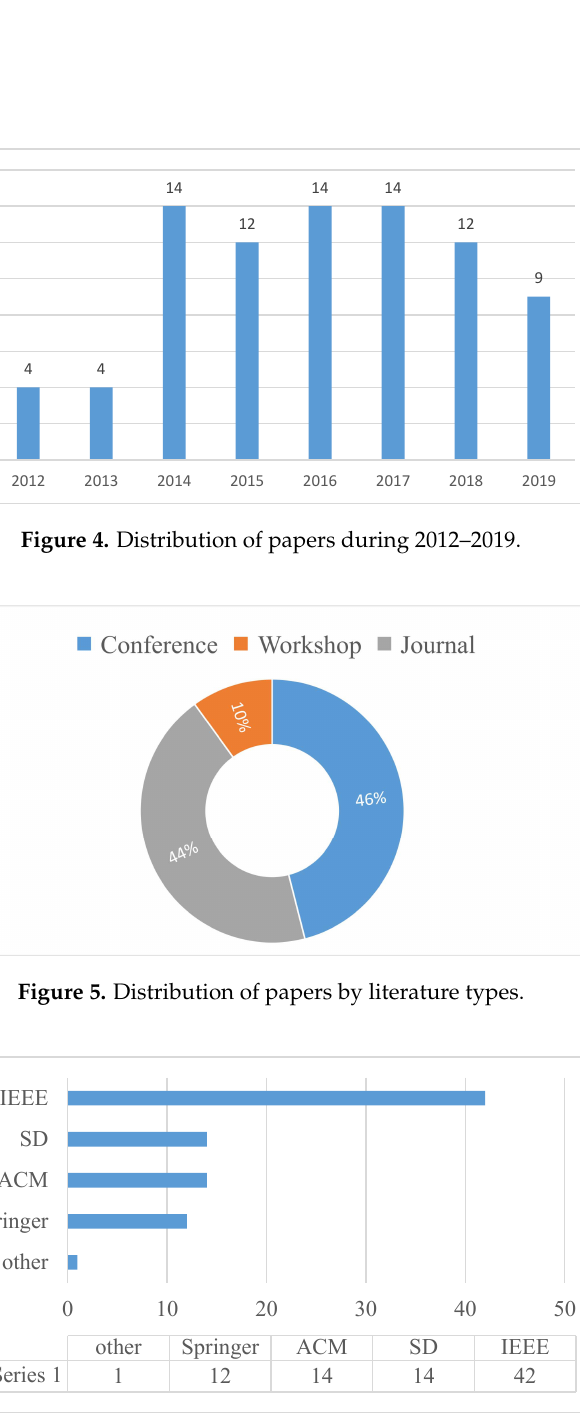
Figure 6. Distribution of papers by